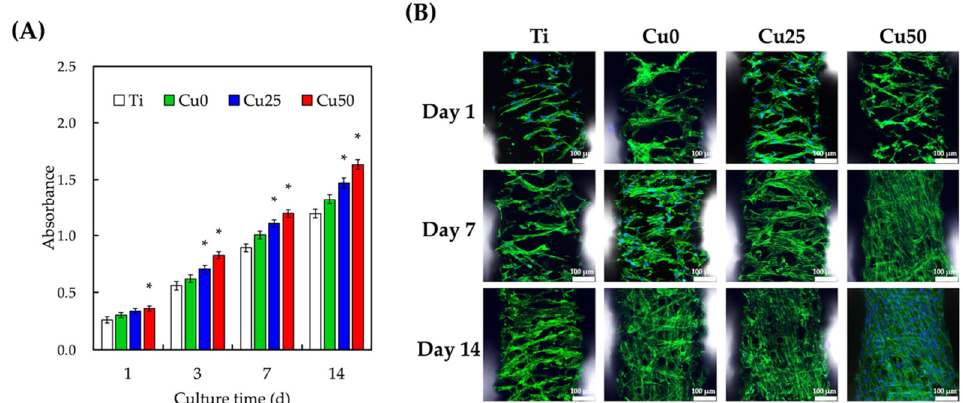
Figure 10. ( A ) Cell proliferation and ( B ) F-actin (green) and DAPI (blue) staining of WJMSCs on the TiPCu 3D scaffolds at various time points. * indicates a significant difference ( p < 0.05) from the Ti group. Data are presented as mean ± SEM, n = 6 for each group. The scale bar is 100 μm.